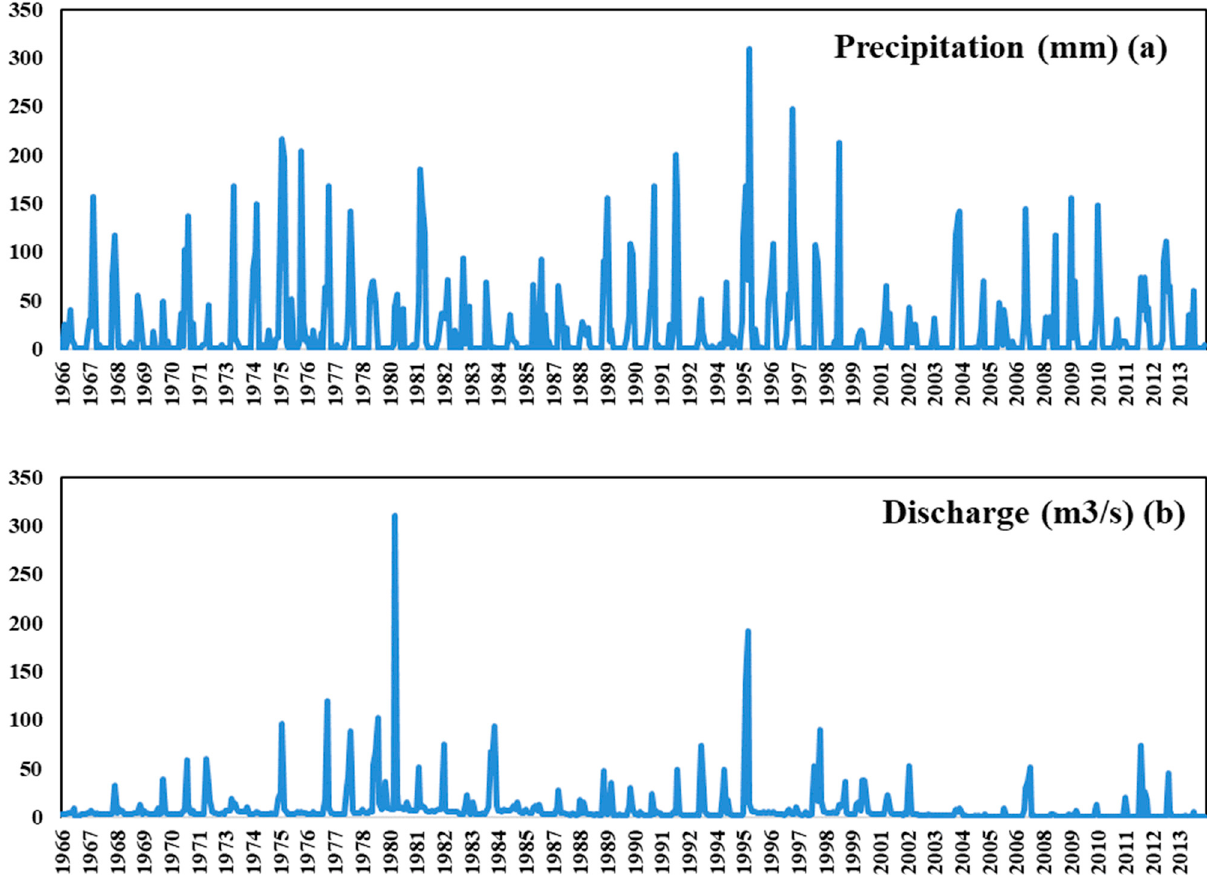
Figure 1. Time series of precipitation ( a ) and discharge ( b ) in the Minab station.